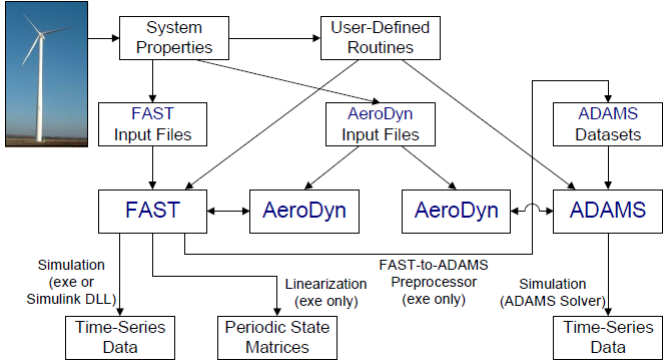
Figure 5. Interaction between each software [25].